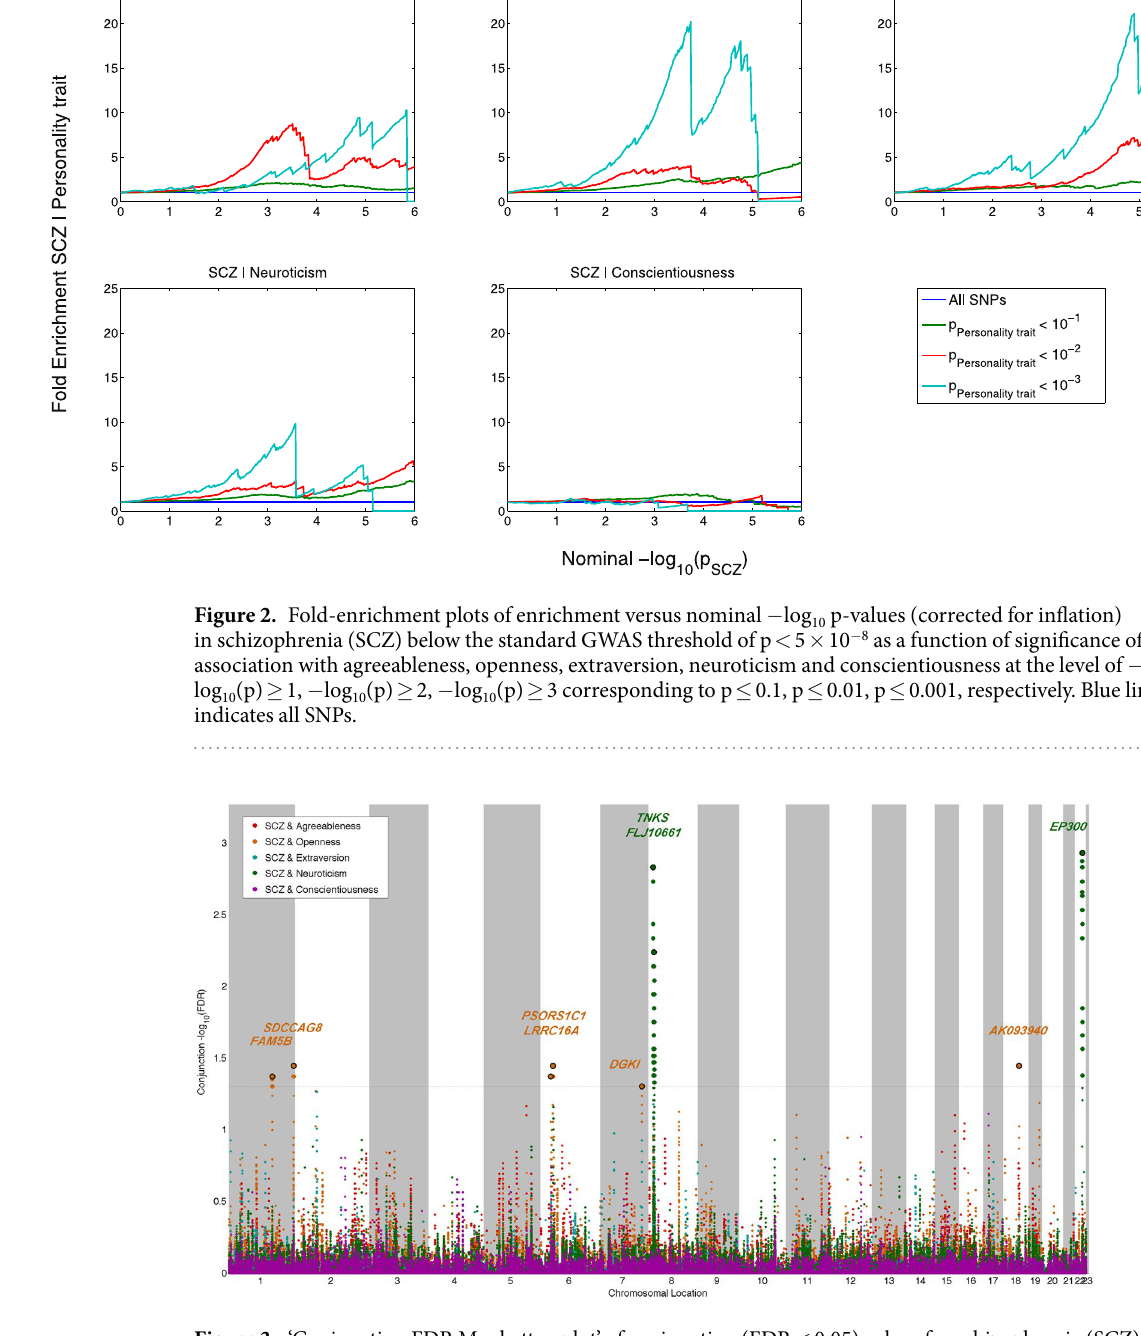
openness and schizophrenia ( BRINP2 , SDCCAG8 , PSORS1C1 , DGKI and AK093940 ), the effect directions were